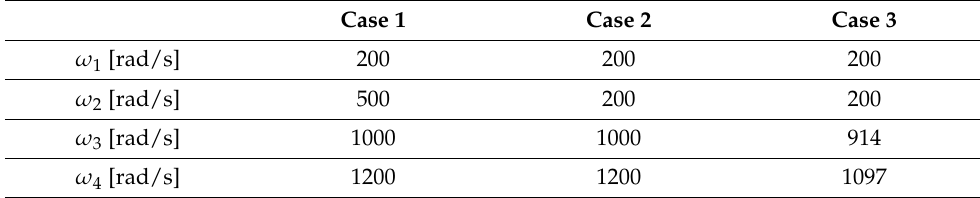
Table 2. Control bandwidths configurations.